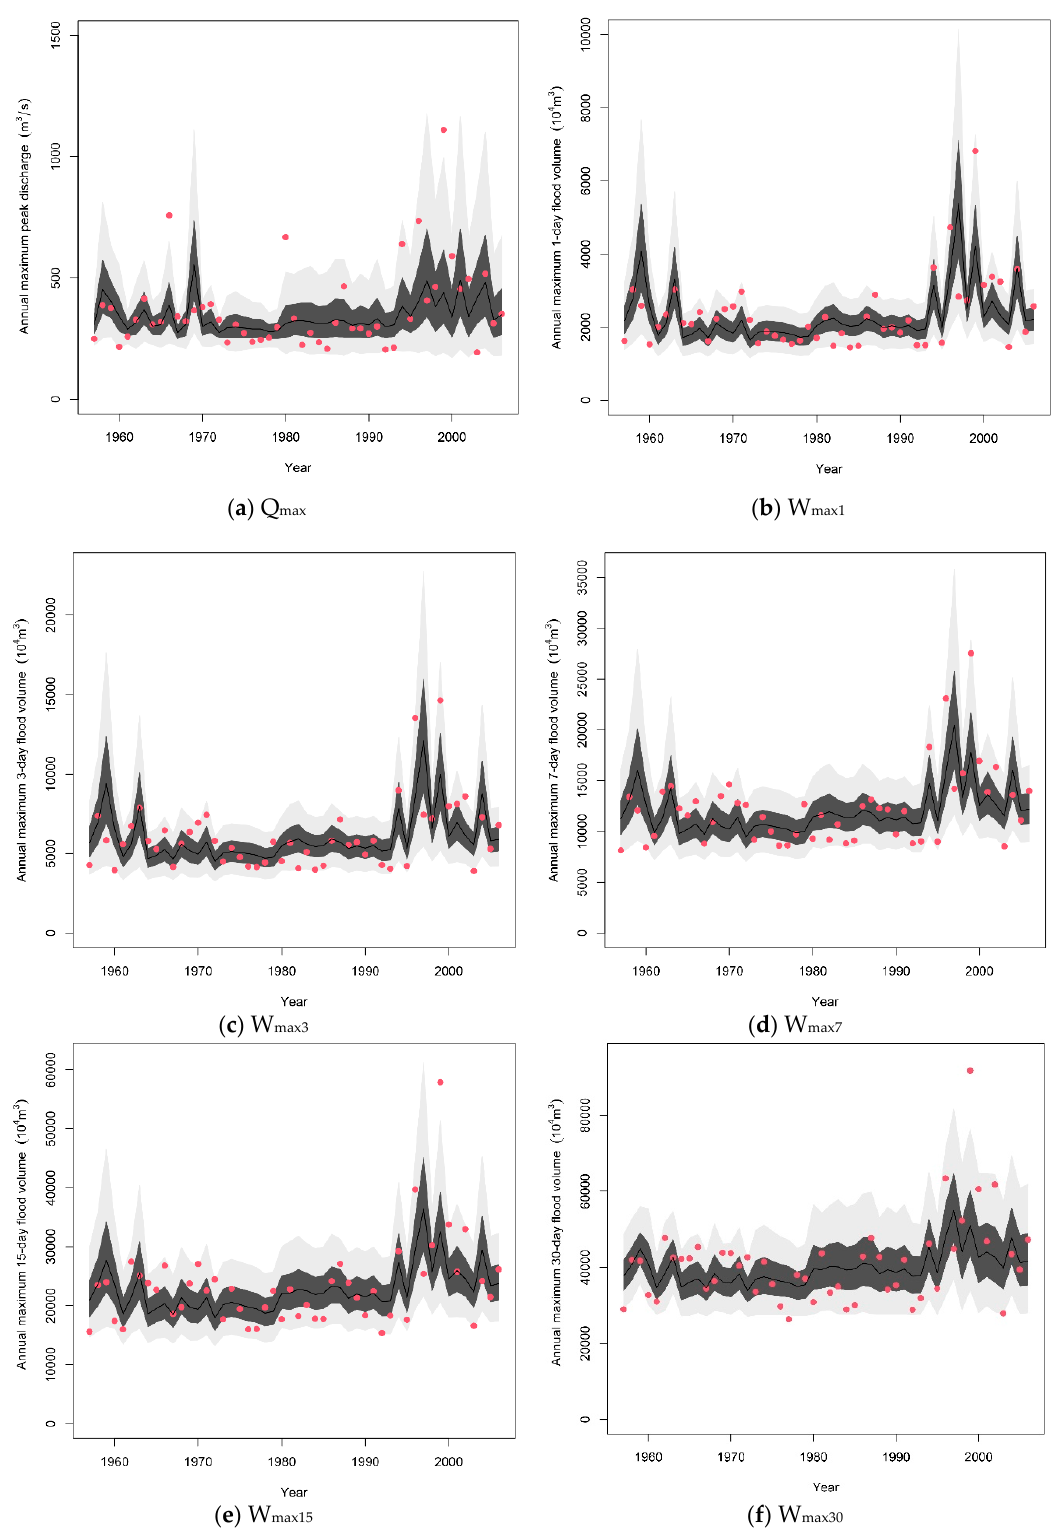
Figure 7. The series of snowmelt flood is modeled using the optimal distribution, with parameters depending on climate factor (Model 2).The red points indicate the actual measured points of the snowmelt flood feature series; the light gray region represents the area between 5th and 25th quantile percentile; the dark gray region in the middle represents the area between 25th and 75th percentile; the upper light gray region represents the area between the 75th and 95th percentile; the middle black curve represents the median (50th percentile).